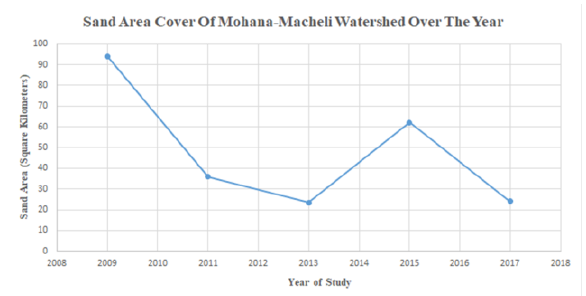
Fig 7: Sand Area Cover of Mohana-Macheli watershed over the year (2009-2017) A Linear regression model of sand cover change was built to predict the future change in sand area which could have a significant effect on the ecosystem of the watershed: